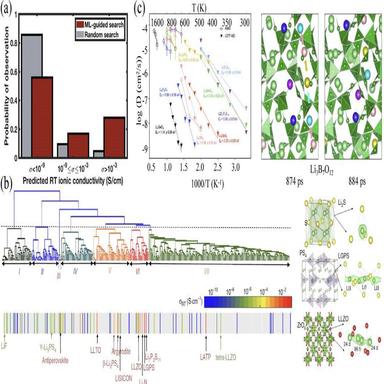
(a) Normalized histogram of predicted room temperature conductivities for the ML-guided material search versus the random search. Reproduced with permission from Ref. . Copyright 2019, American Chemical Society. (b) Unsupervised clustering of all Li-containing compounds. Reproduced with permission from Ref. . Copyright 2019, Springer Nature. (c) Diffusivities simulated by MD at high temperatures and by LOTF-MD at intermediate temperatures and corresponding LOTF-MD snapshots. Reprod